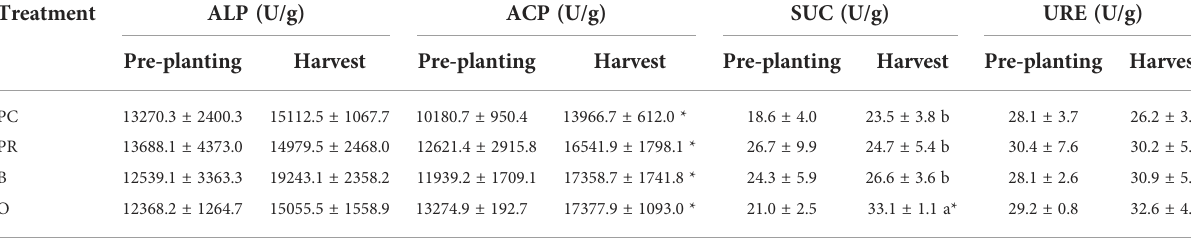
TABLE 2 Soil enzyme activities at pre-planting and harvest in different cropping systems in 2021. Treatment